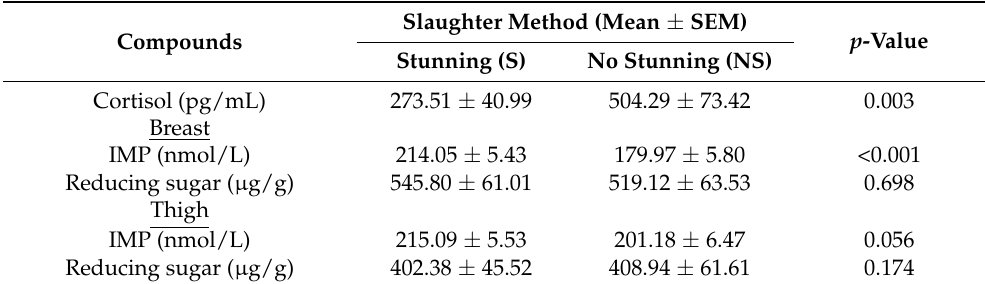
Table 2. Chemical properties of breast and thigh muscles of broiler chickens in the stunned (Treat- ment S) and unstunned (Treatment NS)